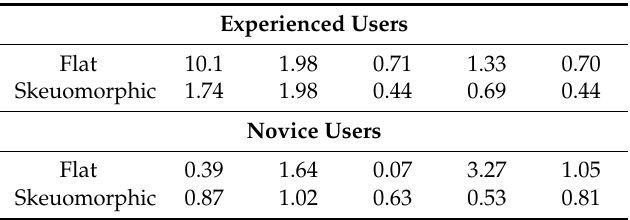
Table 2. First fixation to click times (in seconds).